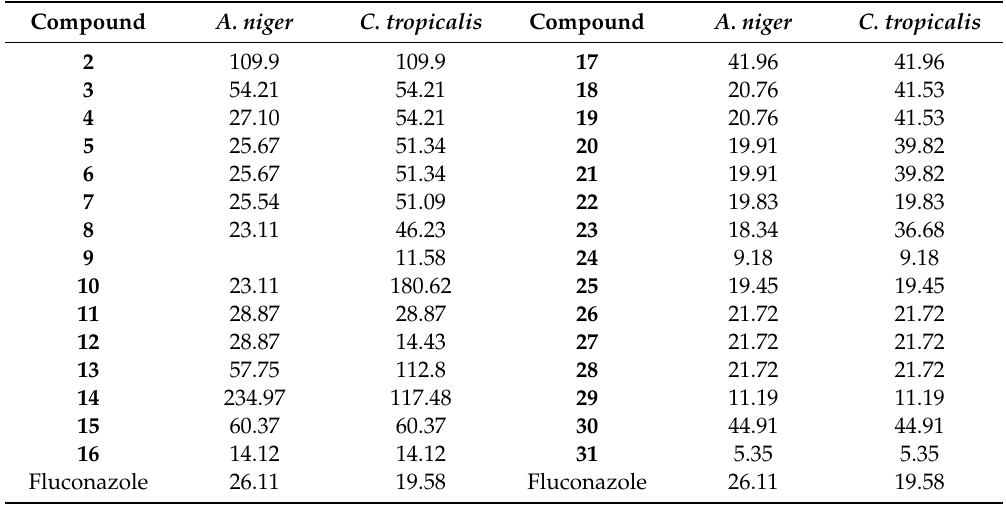
Table 1. Antifungal activities (MIC in µ M) of chalcones ( 2 – 16 ) and dihydropyrazoles ( 17 – 31 ).